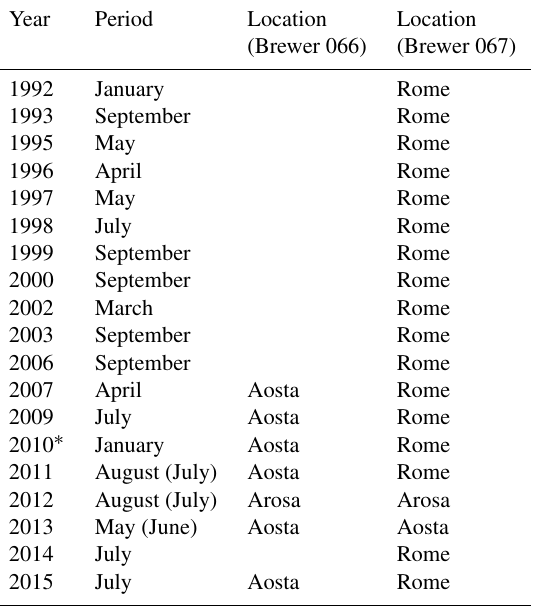
Table 2. Calibration history of Brewer 066 and 067. In brackets the month of the calibration for Brewer 067 is reported. In one case the calibration of Italian Brewer instruments was performed in Arosa (Switzerland) at the Lichtklimatisches Observatorium during the Seventh Intercomparison Campaign of the Regional Brewer Cali- bration Center Europe (WMO-GAW, 2015). In 2013 the calibration of both Brewer instruments was carried out at